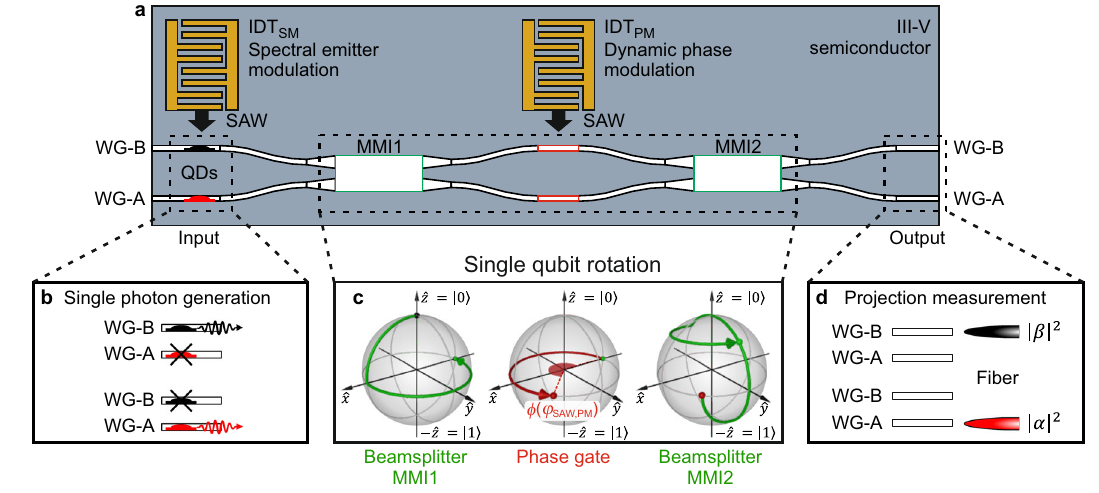
Fig. 1 | Device and qubit rotation. a Schematic representation of the dynamically tuneable ridge waveguide integrated quantum photonic circuit (IQPC). The con- cept, based on a Mach Zehnder Interferometer (MZI) comprises two input wave- guides (Input WG-A and Input WG-B) connected to a 2 × 2 multimode interference device (MMI1)whose outputs are connected by twoWGsto MMI2 withtwo output WGs (Output WG-A and Output WG-B). Two interdigital transducers (IDTs) gen- erate SAWs for spectral modulation of single QDs (IDT SM ) in the Input WGs and